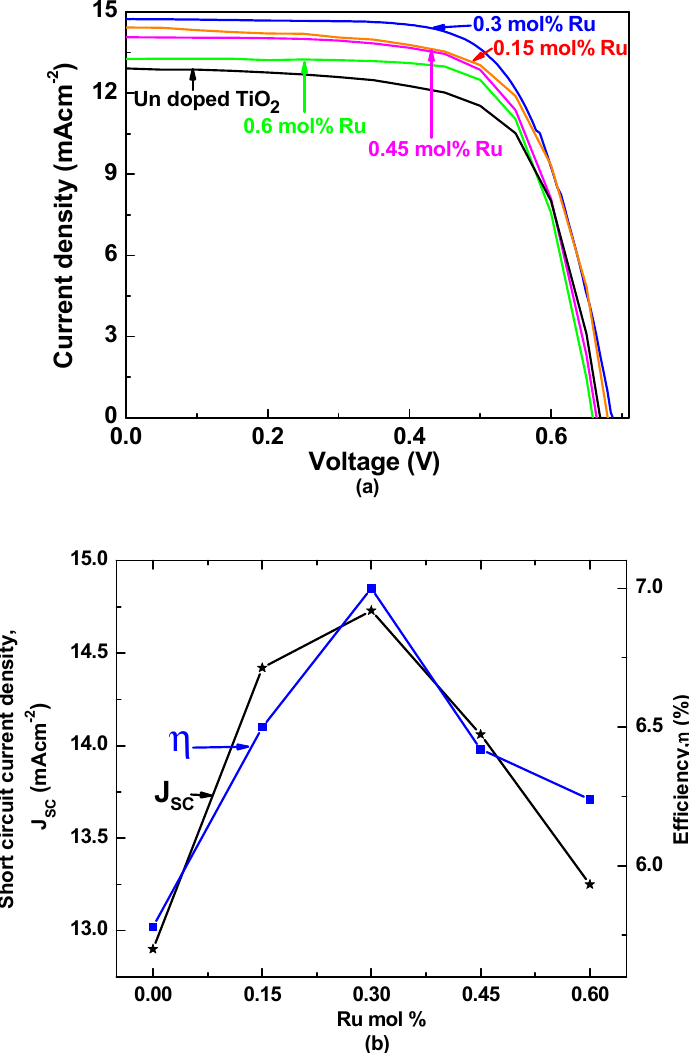
Figure 6. ( a ) Current–voltage (J–V) characteristic curves of the dye-sensitized solar cells (DSSCs) assembled with 0.15, 0.3, 0.45 and 0.6 mol% Ru-doped TiO 2 photoanodes and its control undoped TiO 2 photoanode under simulated irradiation of intensity 100 mWcm − 2 with AM 1.5 filter; ( b ) variations in Jsc and η with different mol% Ru dopants). Table 2. Current-voltage (J–V) characteristics of the DSSCs assembled with different mol% Ru-doped P25-TiO 2 photoanodes and its control P25-TiO 2 photoanodes.